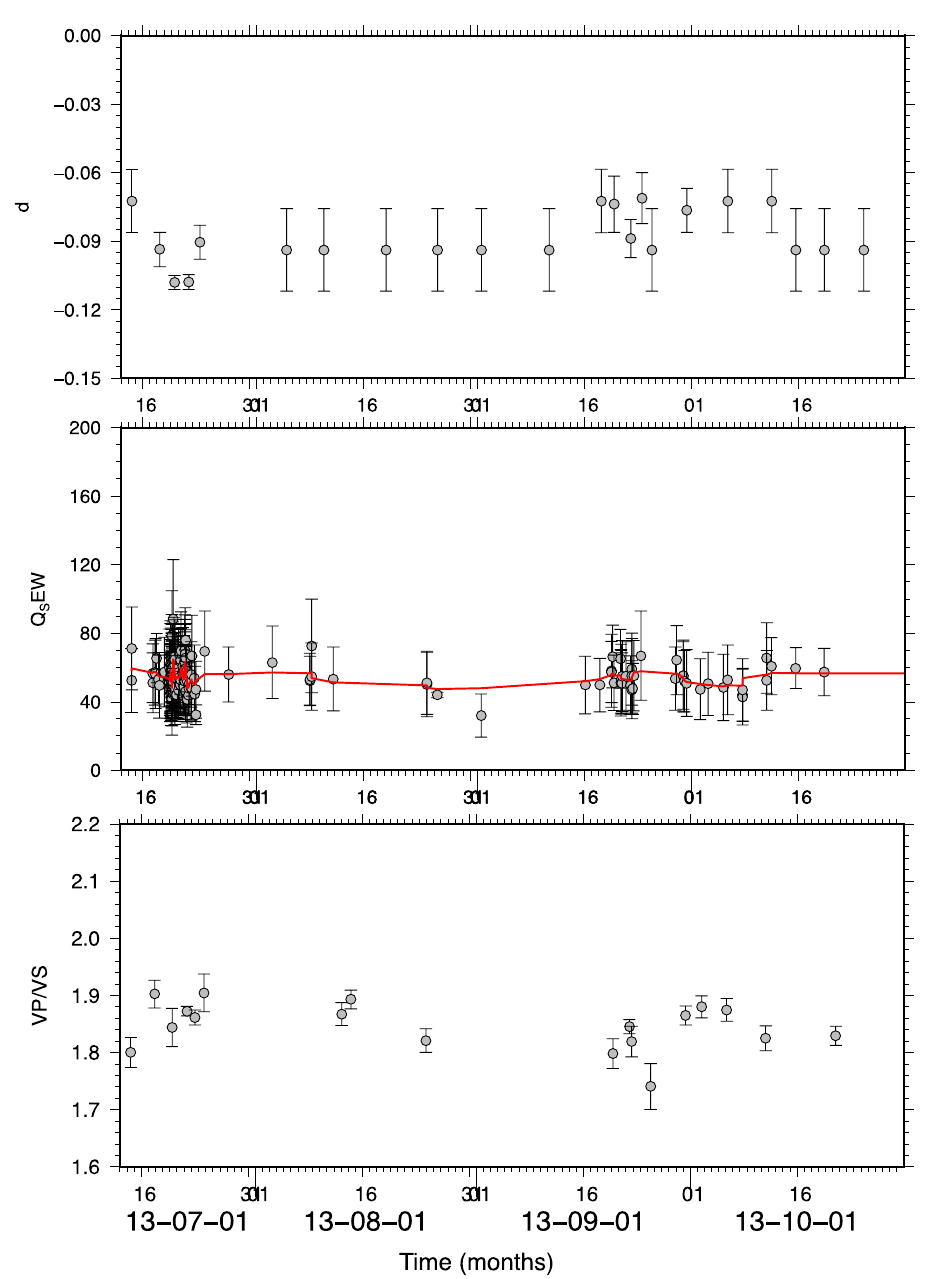
Figure 7. Same as Fig. 5 but for St. Gallen geothermal field for the whole